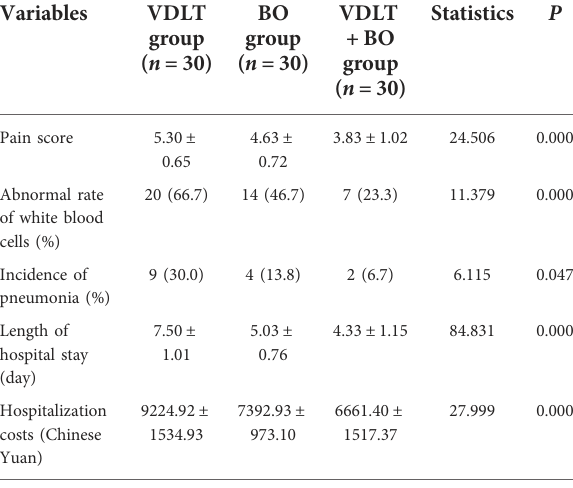
TABLE 5 Comparison of postoperative